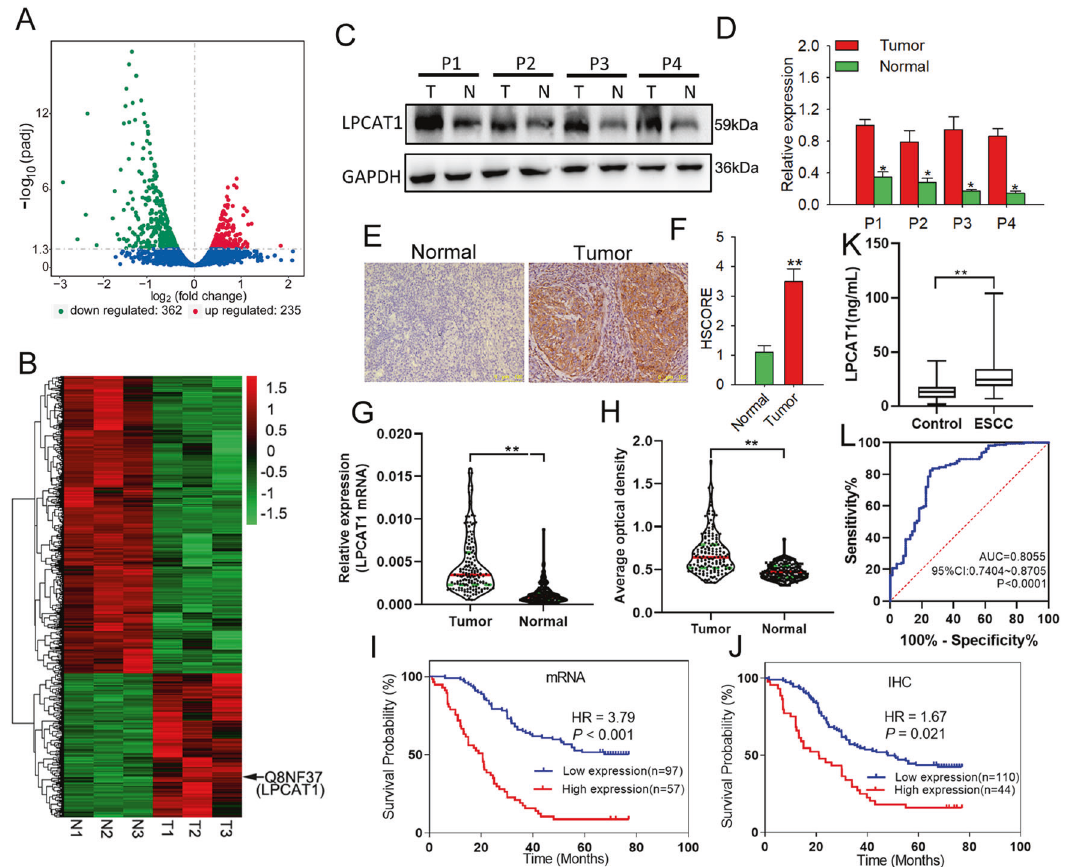
Fig. 1 LPCAT1 is highly upregulated in esophageal squamous cell carcinoma and correlates with poor patient prognosis. A Volcano plot compared the expression fold changes of the genes for ESCC tissues versus adjacent normal tissues. The red dots represent the genes with signi fi cantly changed expression level. B Clustered heat map for all genes with altered expression, with rows representing gene and columns representing tissues. C , D Expression levels of LPCAT1 in ESCC tumor and normal tissues were determined using western blotting analysis. Data are shown as relative expression means and P value from three independent experiments. E Expression levels of LPCAT1 in tumors were determined using immunohistochemistry analysis. Histograms show the means and P value from three independent experiments. F Statistical analyses of the LPCAT1 in tumor tissues. G The mRNA of LPCAT1 in 185 ESCC and normal tissues was determined using qRT-PCR, ** P < 0.01 via unpaired t test. H The protein of LPCAT1 in 185 ESCC and normal tissues was determined using immunohistochemistry analysis, ** P < 0.01 via unpaired t test. I Statistical analyses of the association between LPCAT1 expression and survival in patients with ESCC. J Statistical analyses of the association of LPCAT1 expression with survival probability in ESCC patients. K Serum LPCAT1 levels in 71 healthy subjects and 154 patients with ESCC. P < 0.01 via unpaired t test. L ROC curve analysis of the value of LPCAT1 in ESCC diagnosis. * P < 0.05. ** P <